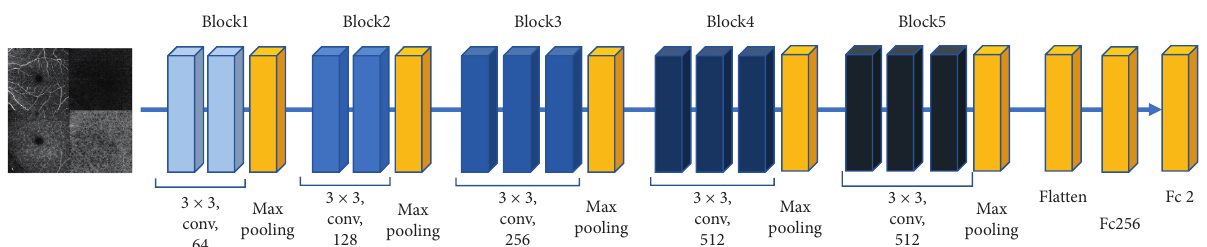
Figure 4: Visual geometry group (VGG) 16 model. The overall architecture of the VGG16 model is shown. The deep convolutional neural network used ImageNet parameters; the weights of blocks 1 − 4 and 5 were fixed, while the fully connected layers were adjusted.